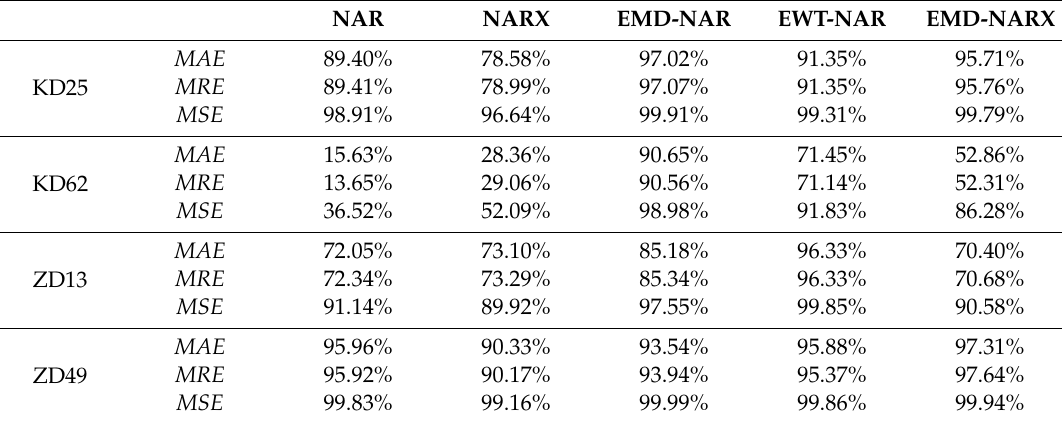
Table 2. The reduction ratio of each model to